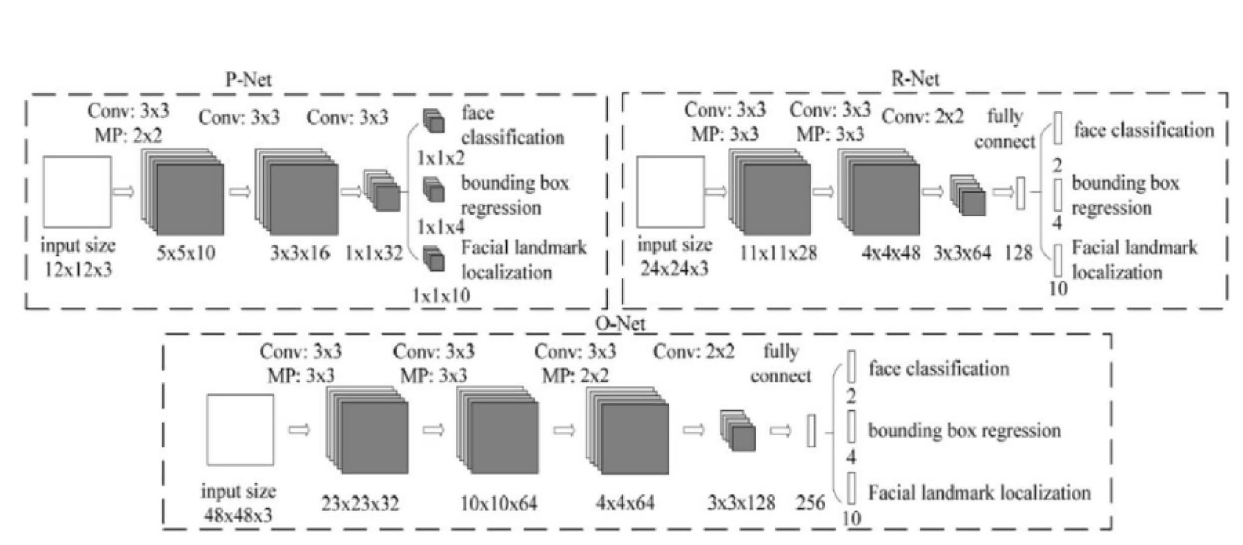
Fig. 3 MTCNN network structure